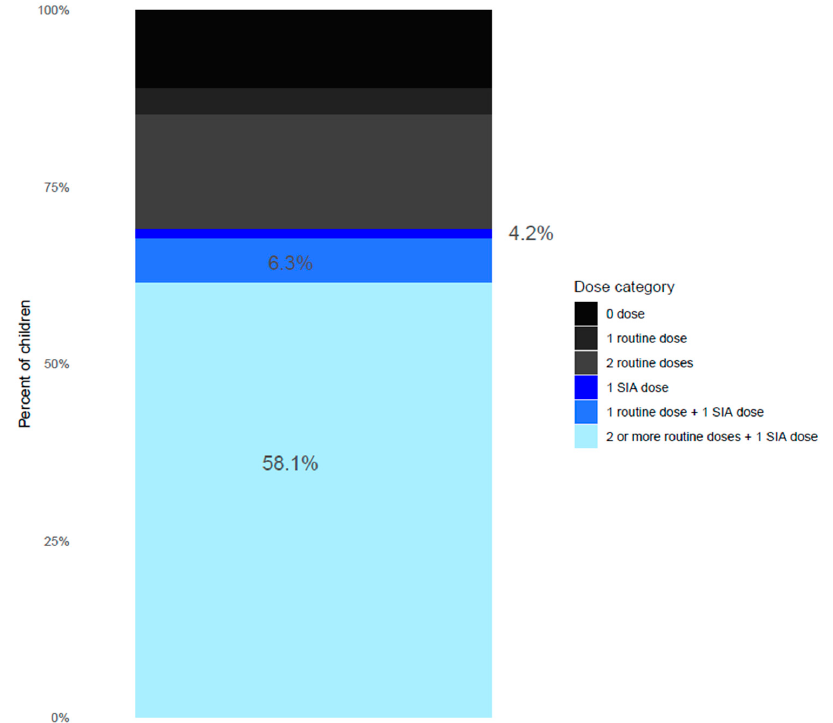
Figure 4. Receipt of measles and rubella vaccine among children 9–59 months post SIA,